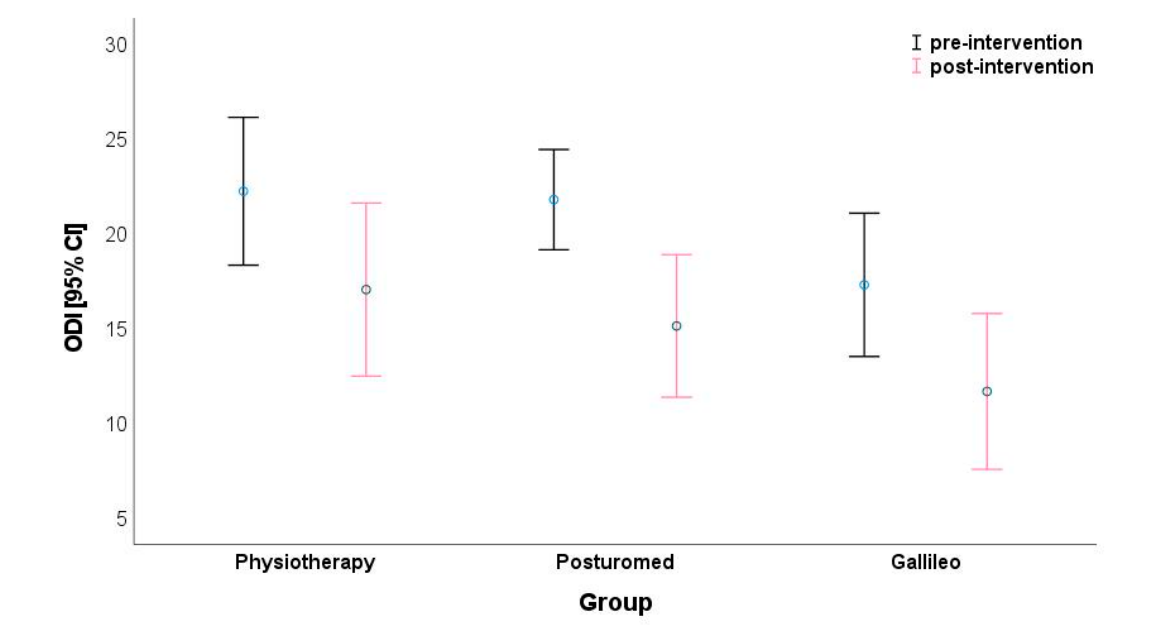
Figure 1. Comparison of the Oswestry Disability Index (ODI) depending on group and time (time effect: p < 0.001; η p2 = 0.470).